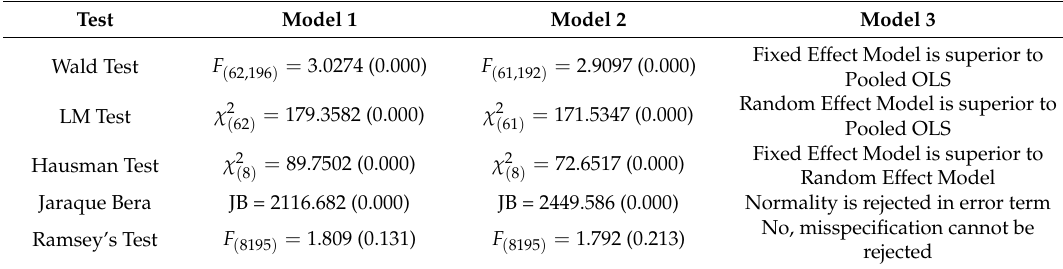
Table A6. Diagnostic tests for Table